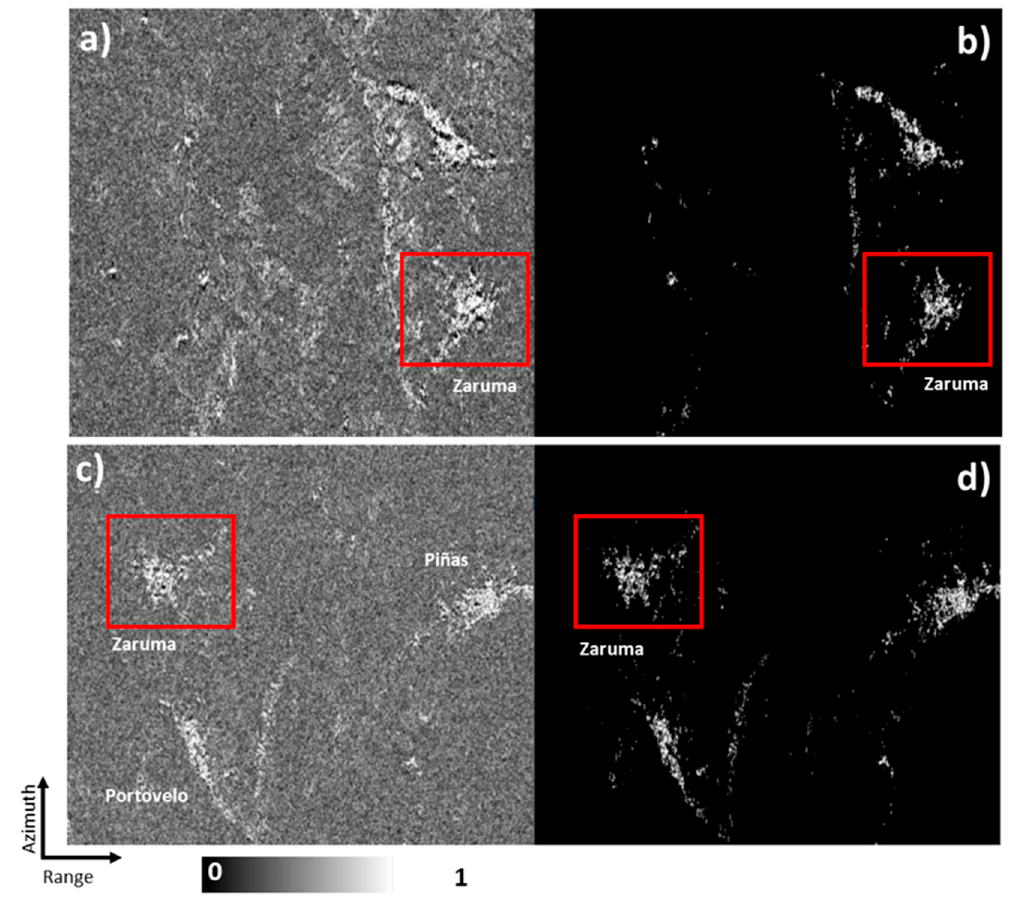
Figure 5. Temporal sublook coherence maps: ascending ( a ), and ( c ). Stable coherence scatterers (SCS) maps: ( b ) ascending, ( d ) descending.